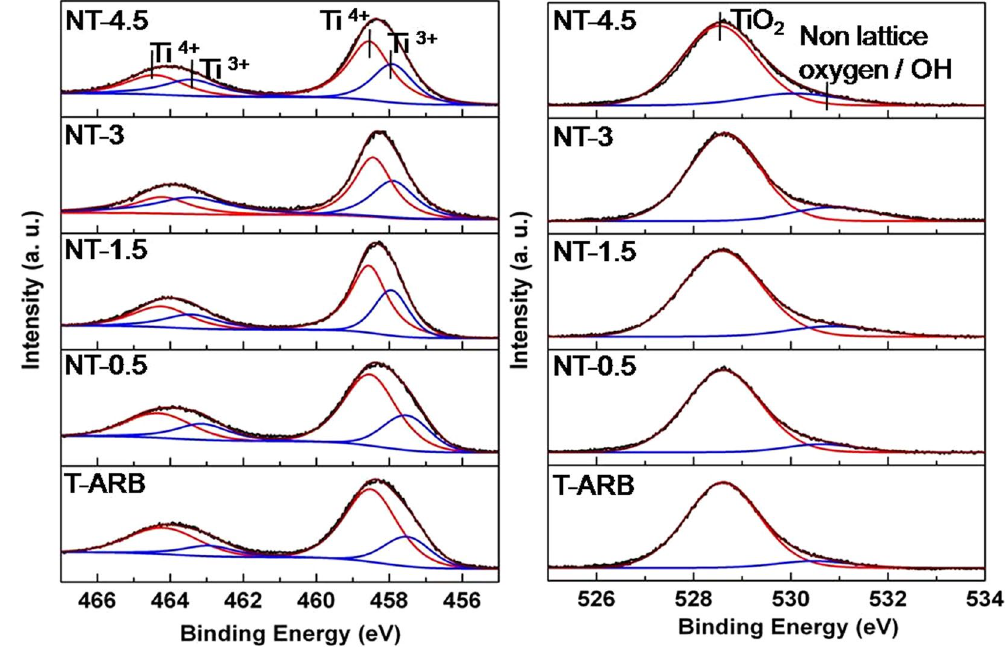
Figure 8. Deconvolution of ( a ) Ti 2p spectra and (b ) O 1 s spectra of pristine and N doped TiO 2